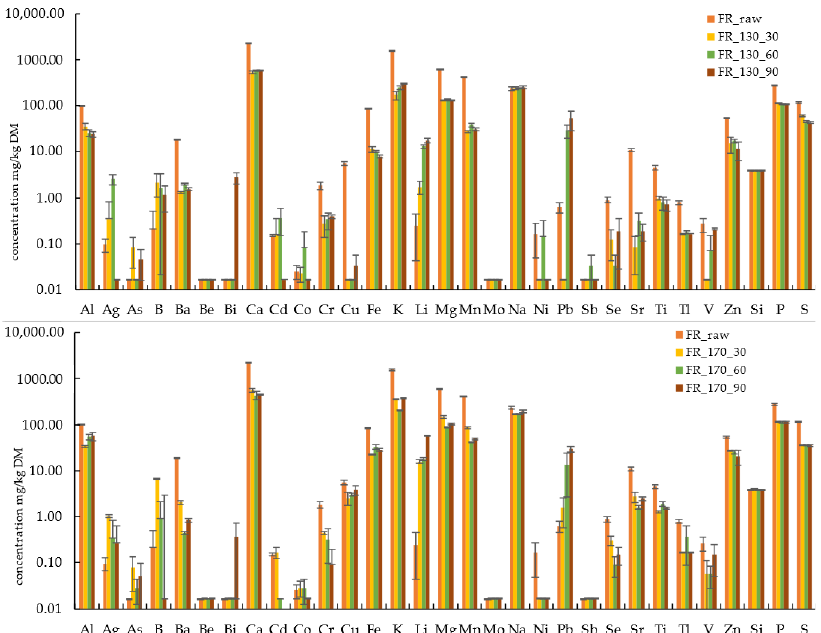
Figure 10. Dry matter (DM) based on mean values ± standard deviations of different elements for raw materials and solids provided by hydrothermal treatment of the digestate (DG) at 130 and 170 °C with 30, 60 and 90 min holding times. Numerical values can be found in Appendix A.